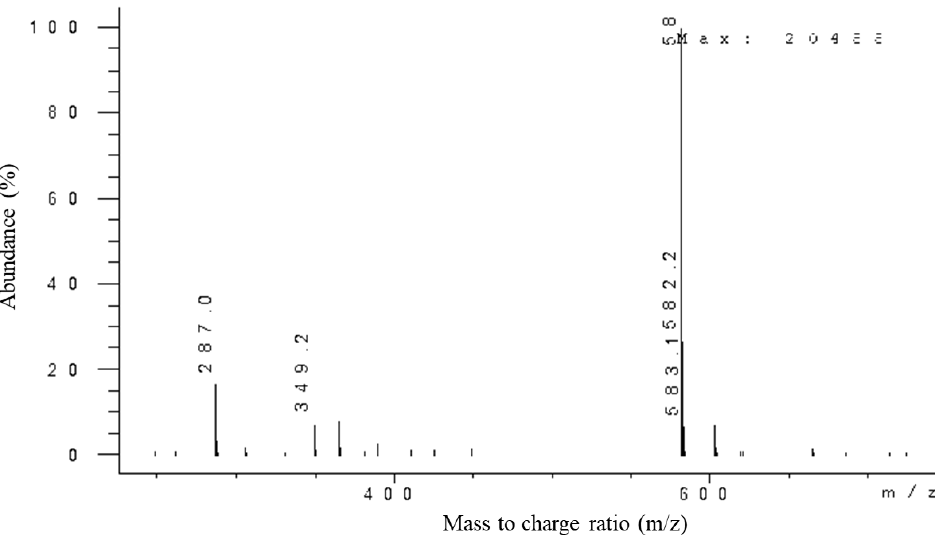
FigureA1. The electro-spray ionization(ESI) massspectrum obtainedfromthe HSCCCpurified Figure A1. The electro-spray ionization (ESI) mass spectrum obtained from the HSCCC purified fraction.